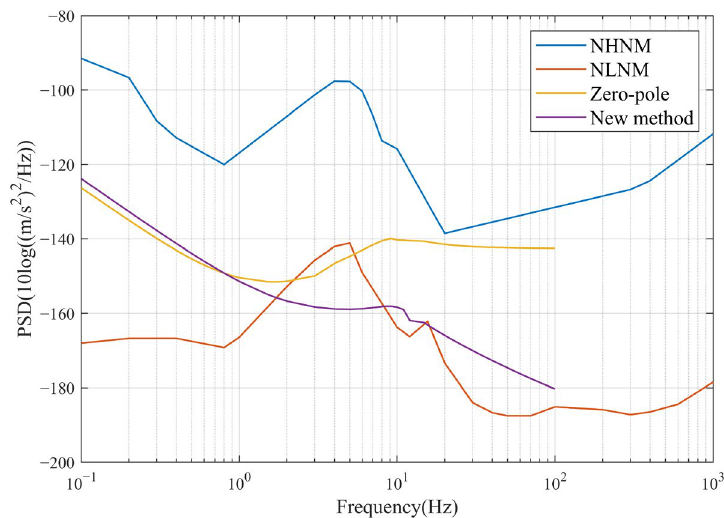
Figure 12. PSD of noise for both methods with NLNM and NHNM.